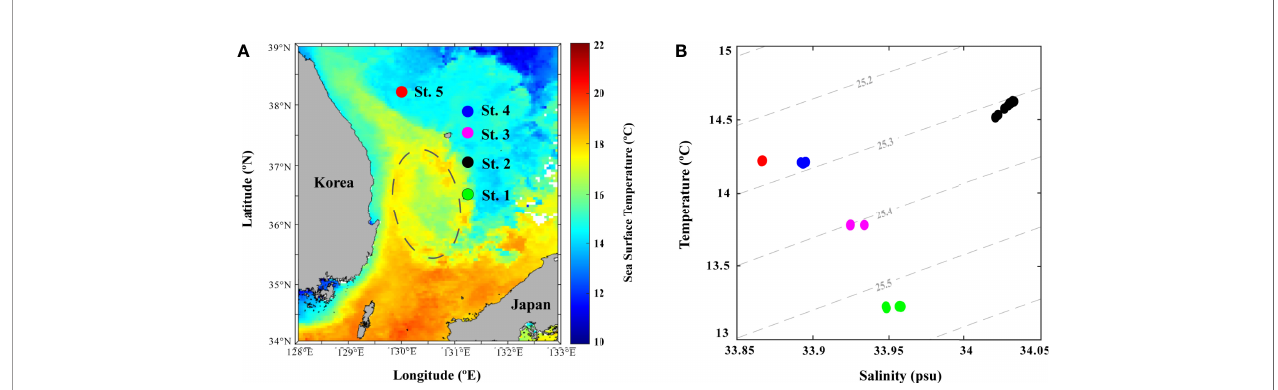
FIGURE 5 | Physicochemical properties of the sampling stations in winter at Ulleung Basin (UB). (A) sea surface temperature gridding map using December monthly data obtained from Ocean Color; and (B) temperature – salinity diagram of 0 – 20-m depth seawater at fi ve